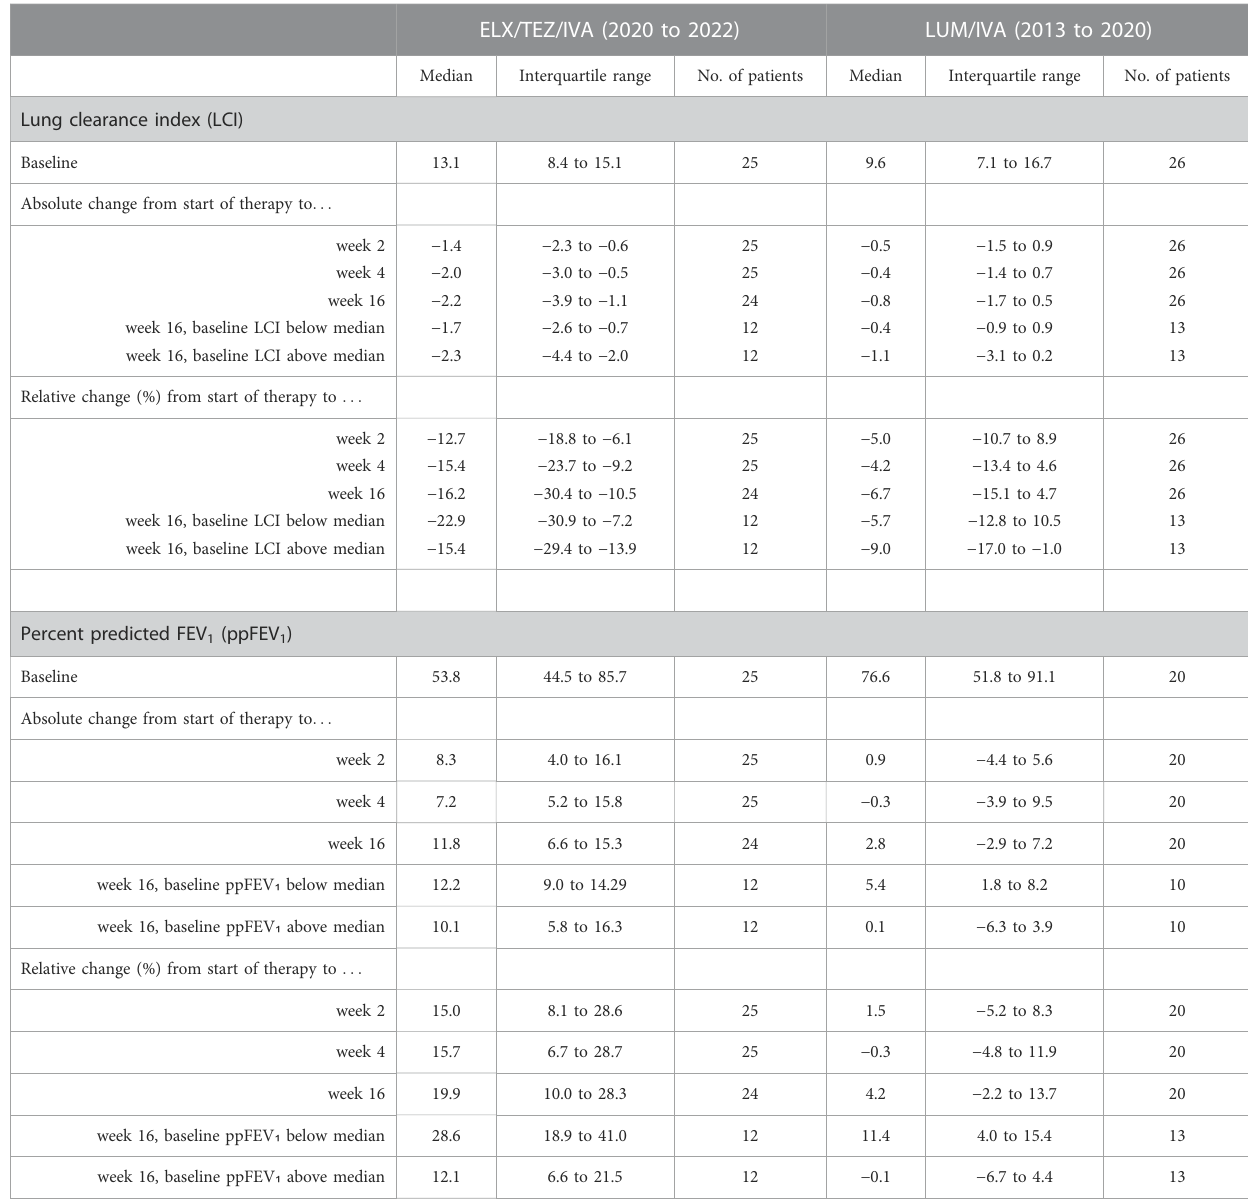
TABLE 2 Response to CFTR modulator therapy. ppFEV ₁ and lung clearance index (LCI) at baseline, and absolute and relative changes at 2, 4, and 16 weeks after initiation ofelexacaftor/tezacaftor/ivacaftor(ELX/TEZ/IVA)or lumacaftor/ivacaftor (LUM/IVA) inpatientswithcystic fi brosis. Six patients werenot abletoperform ppFEV ₁ measurements due to age < 6 years. Repeated measures ANOVA showed signi fi cant( p < 0.0001) bene fi ts during ELX/TEZ/IVA treatment ateach time point comparedtobaseline. SubgroupanalysesrevealedgreaterimprovementsinLCIandppFEV ₁ inpatientswithworselungfunction,i.e.LCIaboveandppFEV ₁ below median,